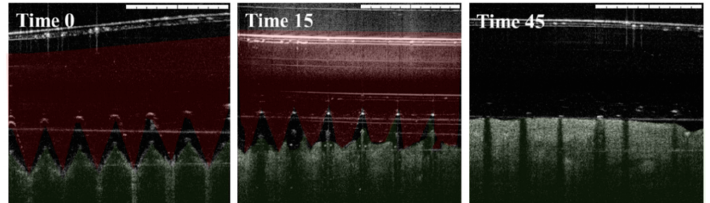
Figure 3. Optical coherence tomographic images of dissolving Gantrez ® AN119 MN in porcine skin. Images show in vitro dissolution kinetics at time 0, 15, and 45 min after insertion in porcine skin. Red color represents needles and green color skin. Scale bars: 1 mm.